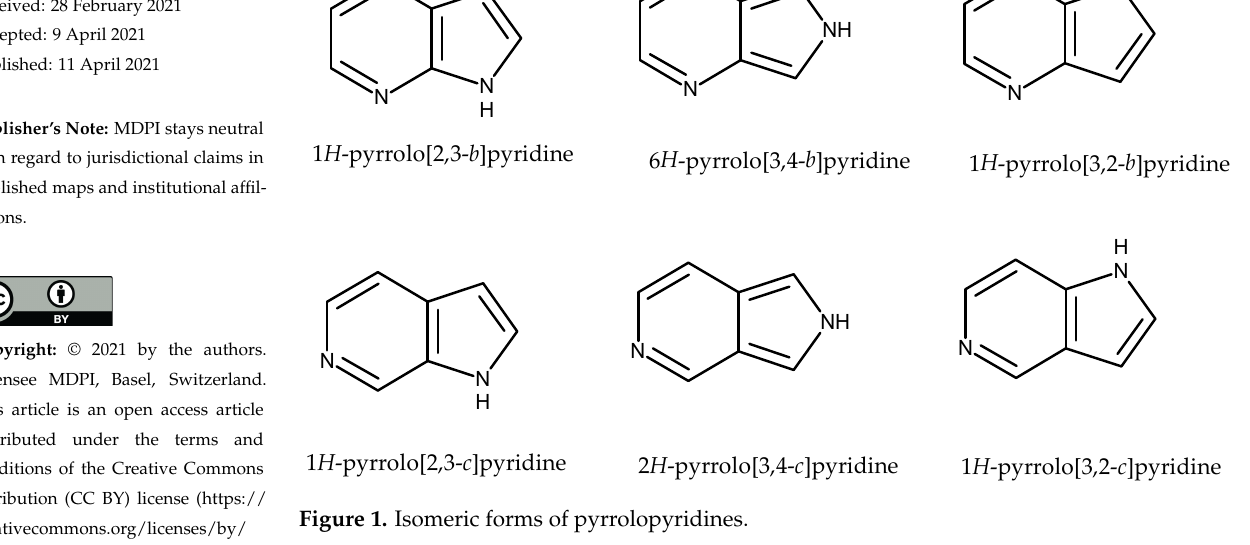
Figure 1. Isomeric forms of pyrrolopyridines.